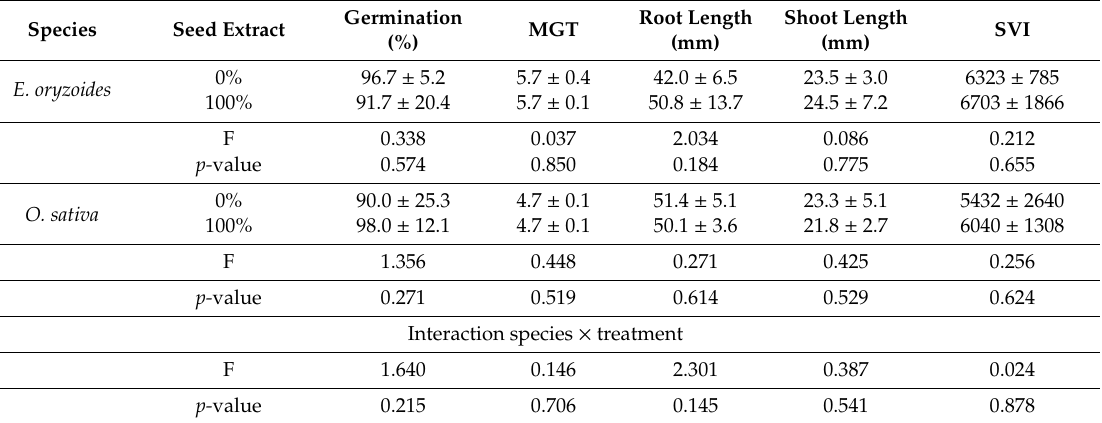
Table 7. Germination indices measured for E. oryzoides and O. sativa under the e ff ect of L. multiflorum seed